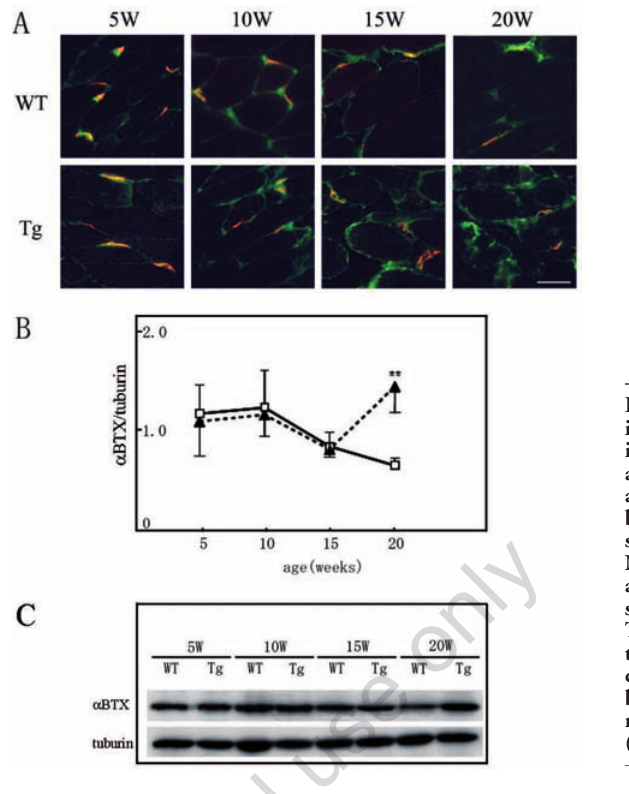
Figure 4. Double immunohistochem- istry of agrin (green) and α -BuTX (red) (A and B), and Western blotting of AChR of soleus muscles (C). Note the increase of agrin in the muscle spaces at 20 weeks in Tg mice (A, B; filled triangles), while no change in α -BuTX between WT and Tg mice in Western blot